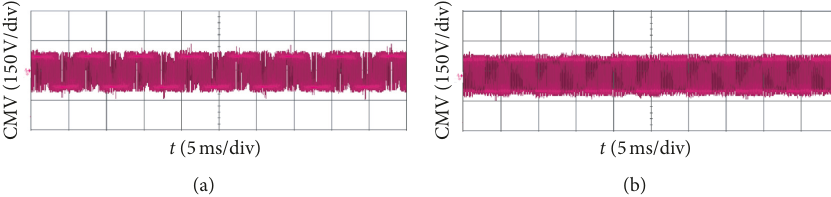
Figure 15: CMV curves. (a) The conventional MPC-RCMV. (b) The proposed MPC-RCMV with constant switching